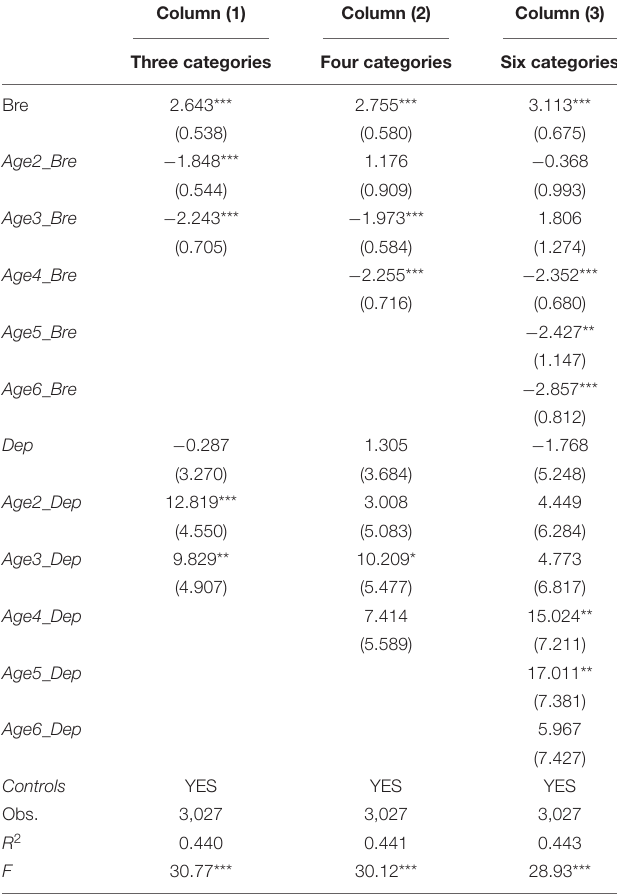
TABLE 4 | Robustness test